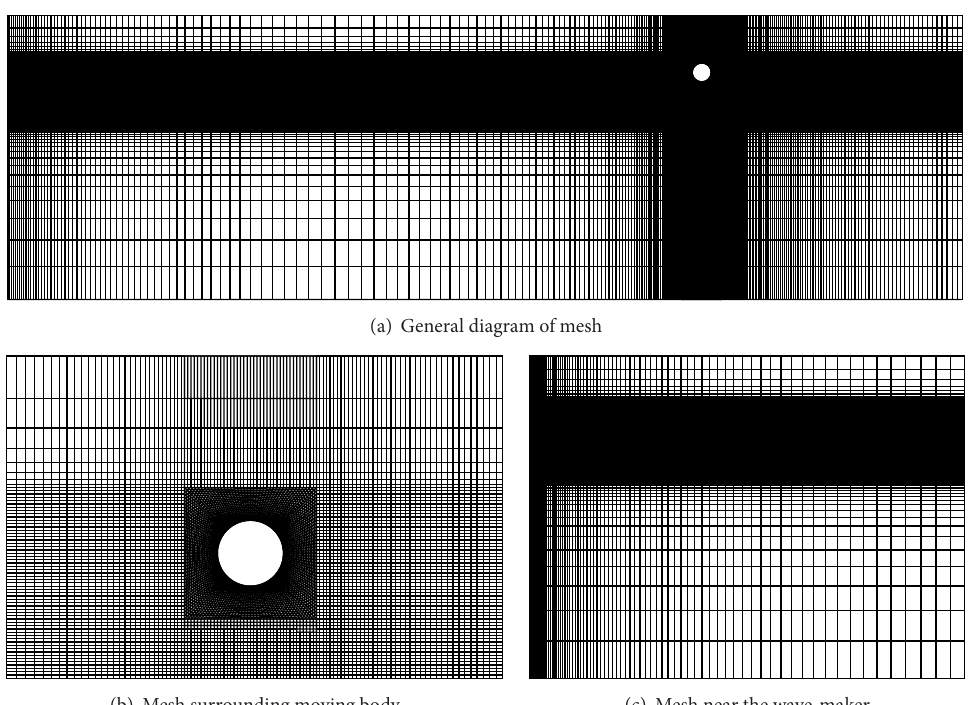
Figure 2: Schematic diagrams of